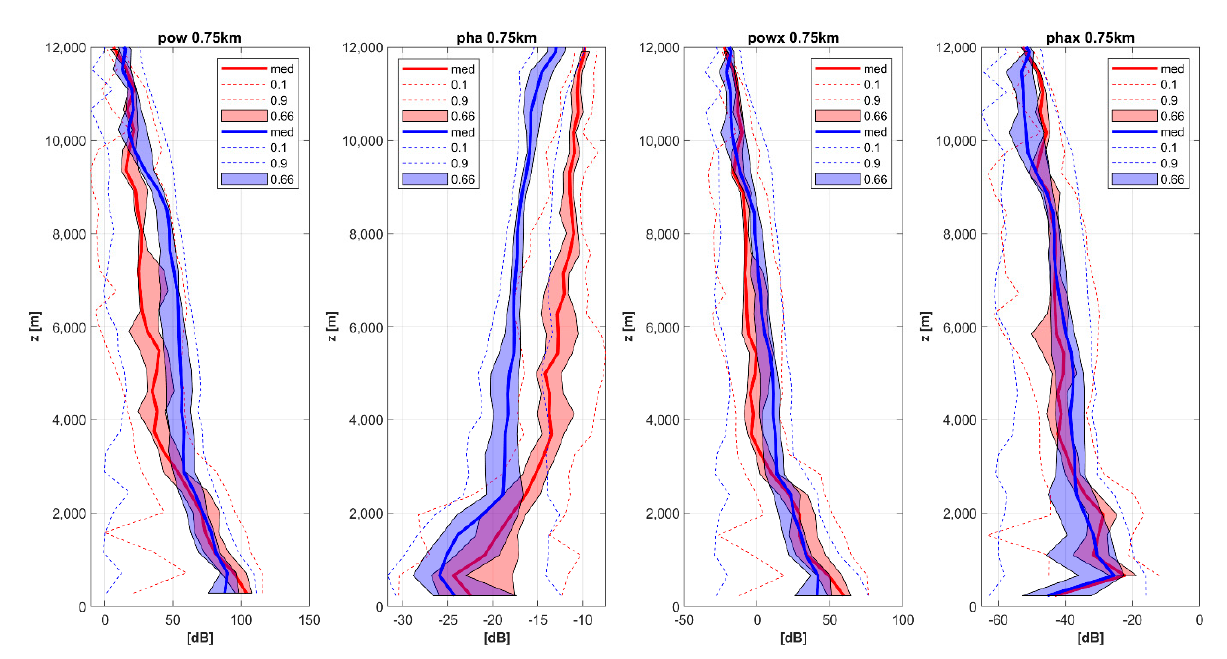
Figure 9. Comparison of statistical characteristics of pow, pha, powx and phax for “near(0.75 km)” and “far” data. Detailed figure caption is given in Figure 7. Both pha and phax are depicted using 10*log10(arctan) for better representation of vertical profiles of the data.